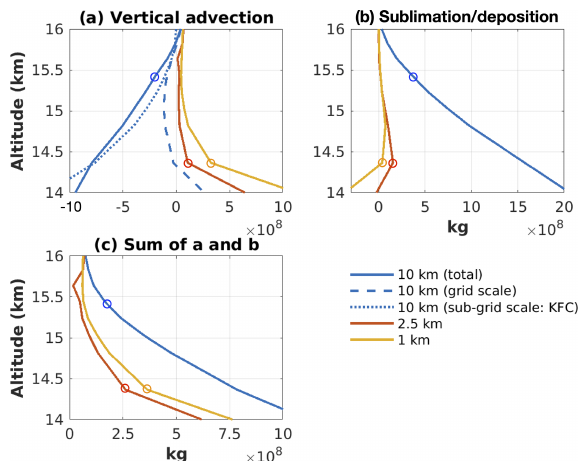
Figure 9. Change of water vapour in Domain A during the 5h evalu- ation period with different altitude levels as the lower boundary. The circles represent the height of tropopause (mean (cid:48) < 2 ◦ Ckm − 1